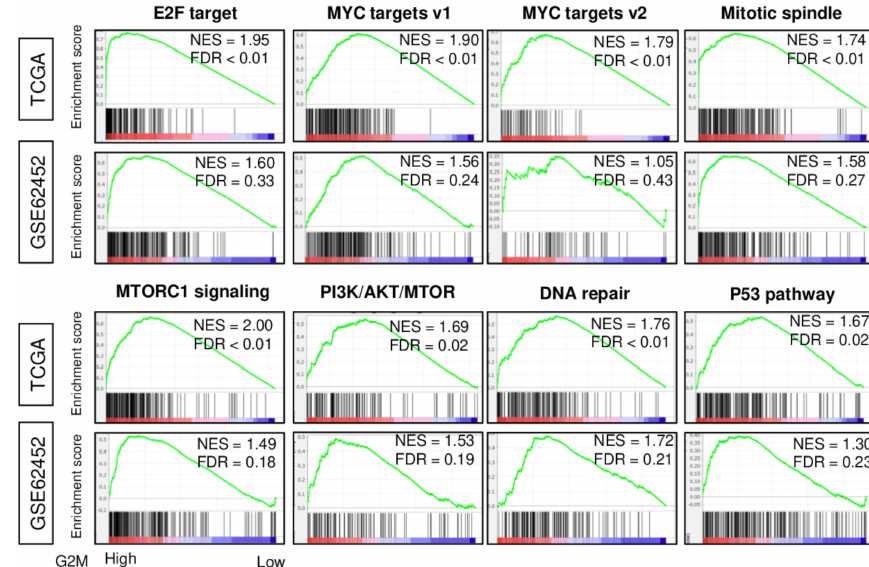
Figure 1. Hallmark gene sets that significantly enriched in high G2M pathway score pancreatic cancer. Gene set enrichment plots along with normalized enrichment score (NES) and false discovery rate (FDR) are shown for the eight ( E2F target, MYC targets v1, MYC targets v2, Mitotic Spindle, MTORC1 signaling, PI3K / AKT / mTOR signaling, DNA repair, P53 pathway) gene sets that significantly enriched in tumors with high compared to low G2M pathway score in both TCGA and GSE62452 cohorts. The G2M score was calculated from tumor gene expression as the single-sample gene set variation analysis score for the Hallmark G2M gene set, and within-cohort median value was used to identify tumors with high and low scores. NES and FDR were determined with the classical GSEA method, where FDR < 0.25 is considered